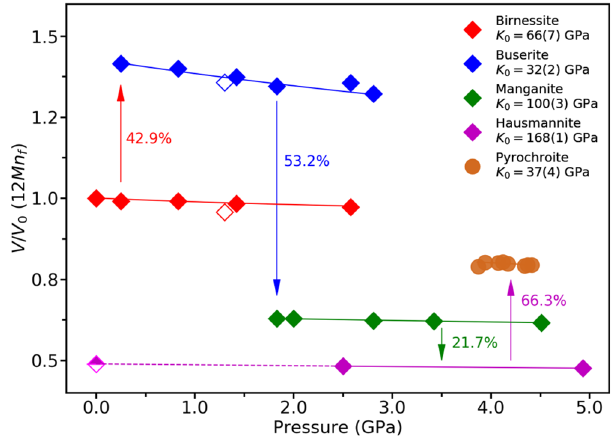
Fig. 2 Changes in the normalized unit-cell volumes of birnessite and successive transformation products as a function of pressure. Unit cell volumes were normalized per 12 manganese atoms (12Mn f ). Open symbols for birnessite and buserite are the data measured at the 6D beamline at PLS-II that have been used for the Rietveld re fi nements, and the circle symbols for pyrochroite were measured at the 13-BM-C beamline at APS. The half- fi lled symbol for hausmannite is after pressure